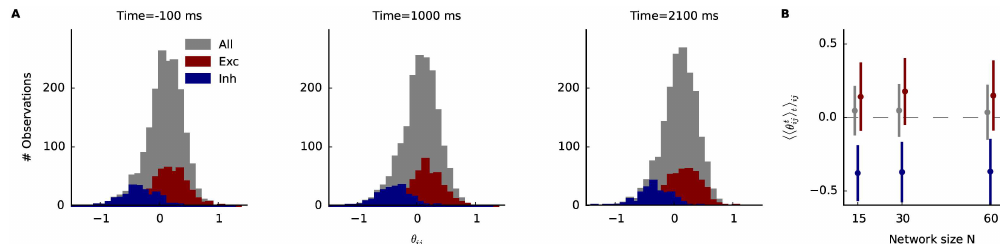
Fig 7. Comparison of model interactions with synapses in the balanced network. The synapticstructure is reflected in the inferred interactions. A Histograms of the interactions y t j T for all pairs (gray), pairs that are connected ij by at least one excitatory synapse (red), and those that are connectedby at least one inhibitorysynapse (blue) at three different time points. B Averages of the couplings y t j T across time and pairs as a function of a network size (always ij consisting of two thirds of excitatory and one third of inhibitoryneurons). Colors as in A, and error bars denote standard